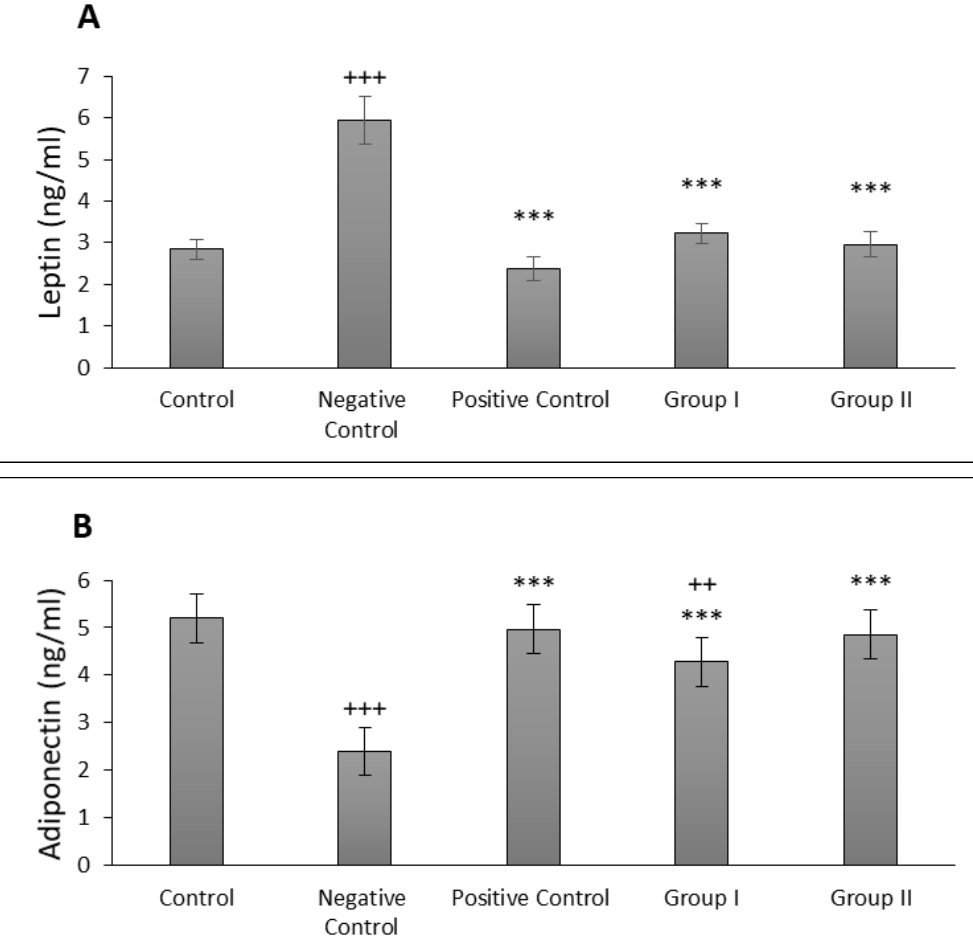
FIGURE 2 – Changes in the levels of leptin (A) and adiponectin (B) affected by 6-gingerol in fatty liver-induced mice. Values are reported as mean ± SD. ++ p <0.01 and +++ p <0.001 as compared with the control group. *** p <0.001 as compared